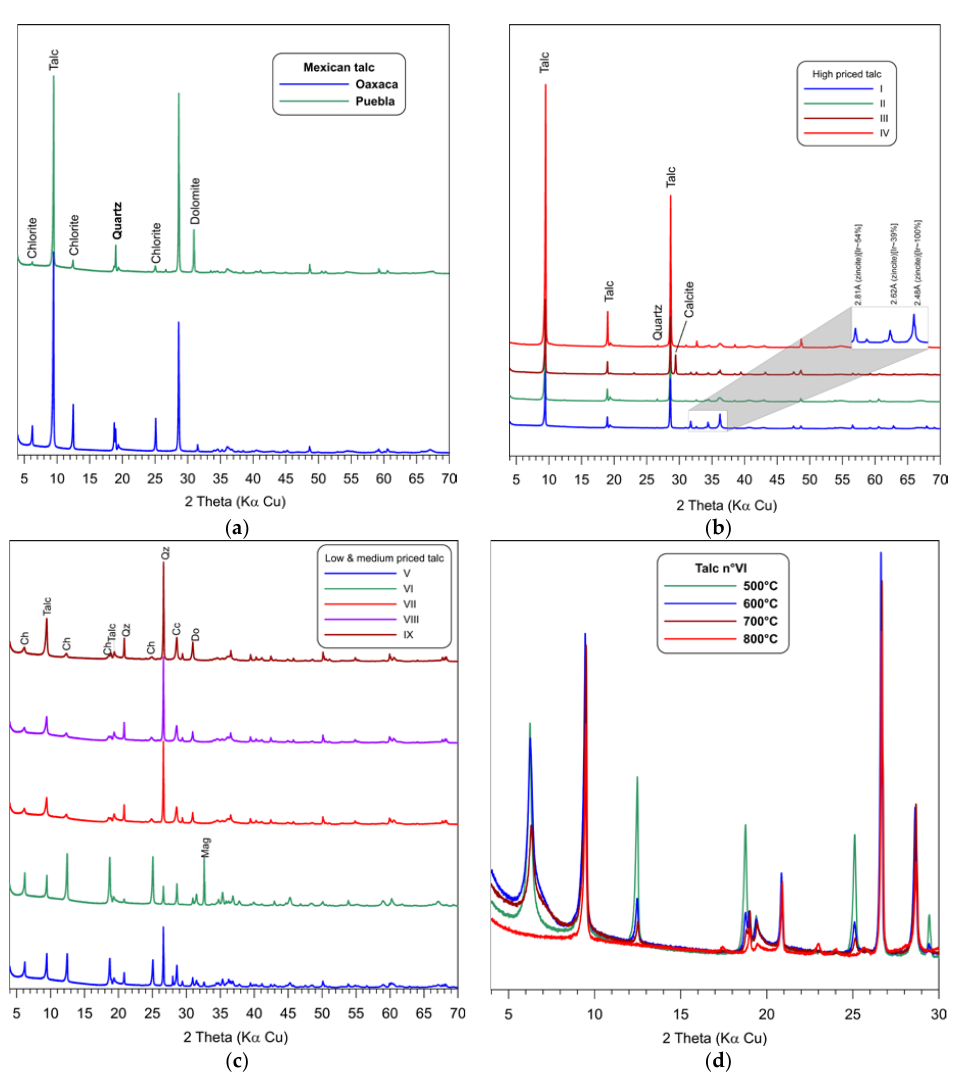
Figure 3. X ray diffraction patterns of three types of talcs: Mexican talc ( a ), high-price imported talc (with zincite) ( b ) and low-medium-price imported talc ( c ). ( d ) Talc VI heated at different temperatures (500–800 °C) to discriminate chlorite and serpentine group minerals.